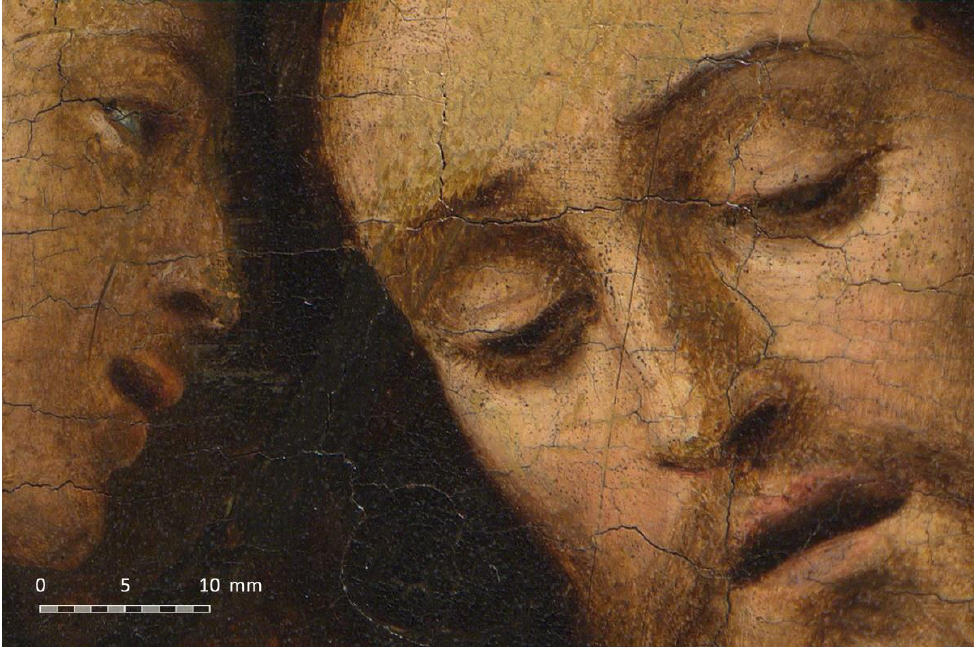
Figure 14. Fragment of the resulting gigapixel image.